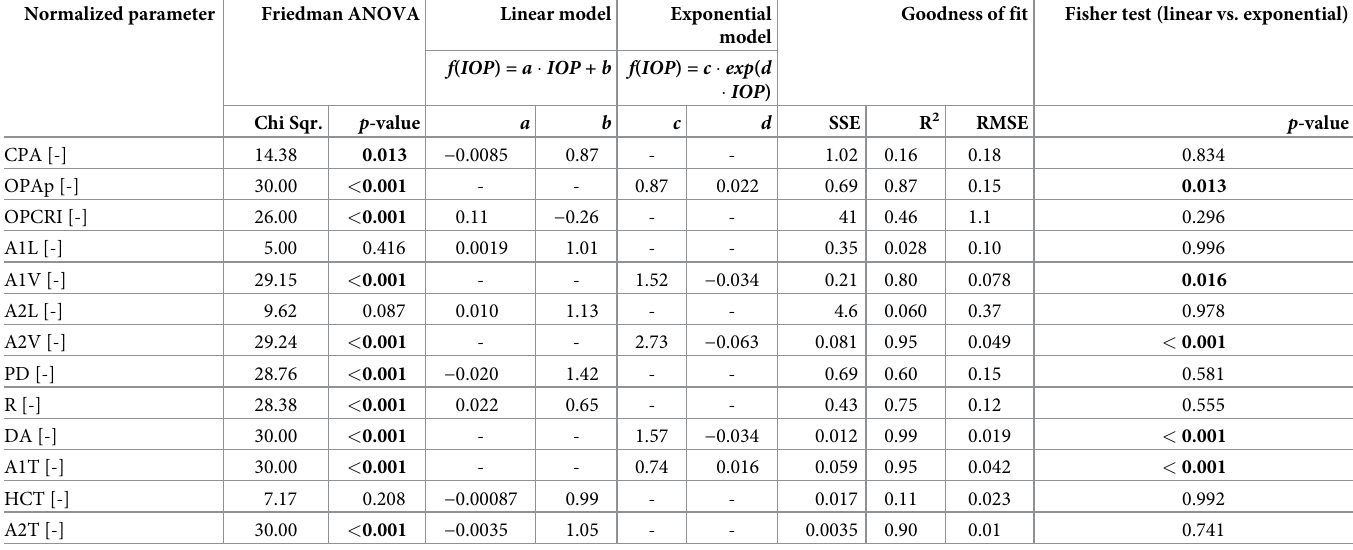
Table 2. Results of the Friedman ANOVA test presenting IOP impact on the changes in the corneal deformation parameters and the ocular pulse signal parameters. In addition, depending on the Fisher’s exact test outcome, either linear or exponential model was applied. Normalized